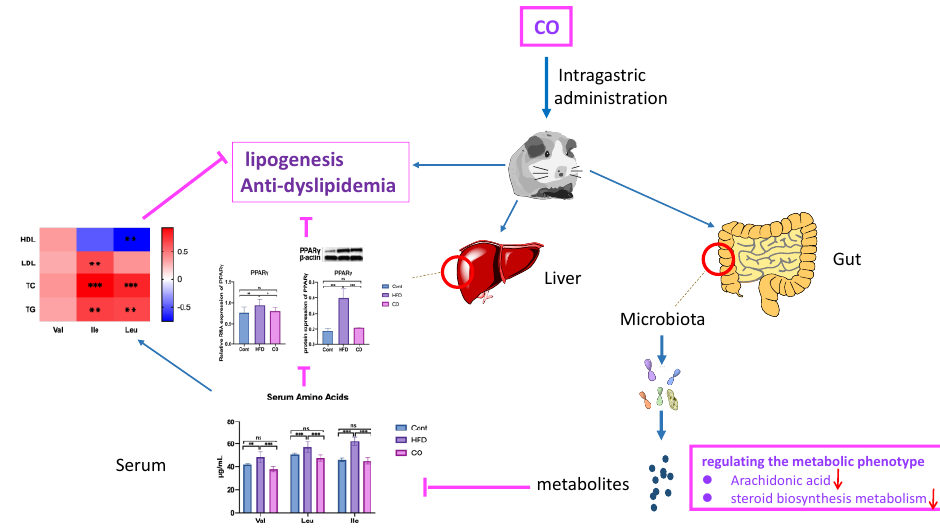
Figure 7. CO enhances the concentration of HDL, but decreases the LDL, TG, and TC levels in serum of HF-fed mice by regulating liver lipid metabolism through the positive correlation between alteration of metabolic phenotype and inhibition of serum BCAA concentration, especially in Ile and Leu. Data are expressed as the mean ± SEM, * p < 0.05, ** p < 0.01, *** p < 0.001, ns p > 0.05.